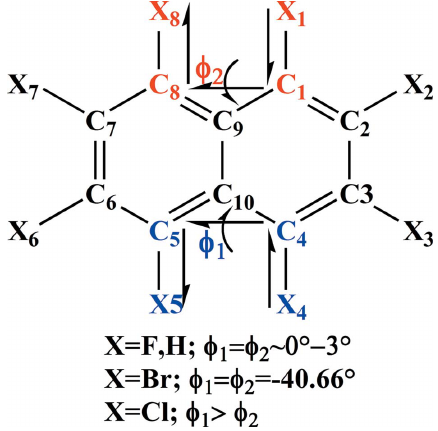
Figure 1 Representation of (cid:6) 1 and (cid:6) 2 dihedral angles in the schematic diagram of naphthalene and